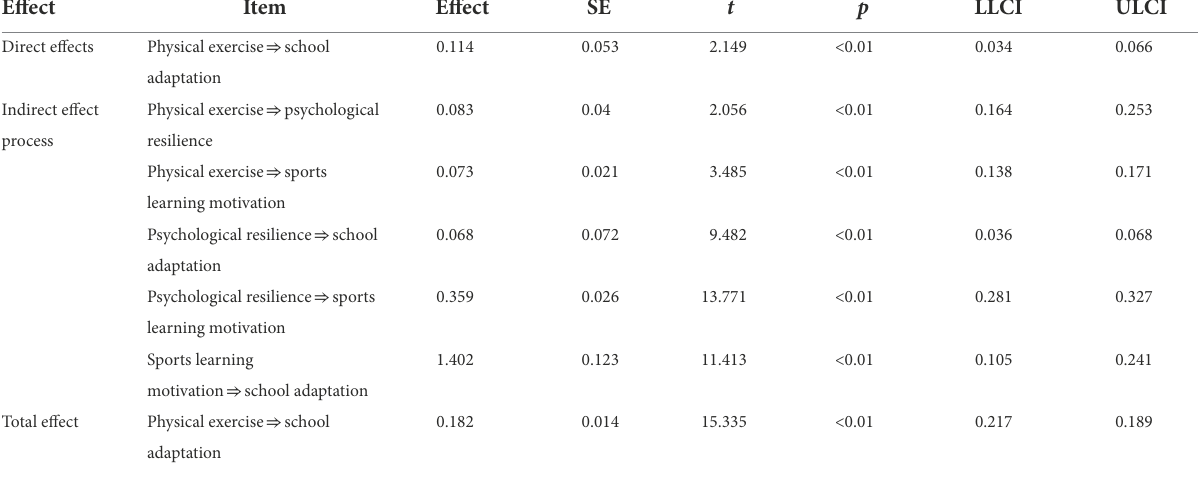
TABLE 3 Analysis of regression relationship of variables.